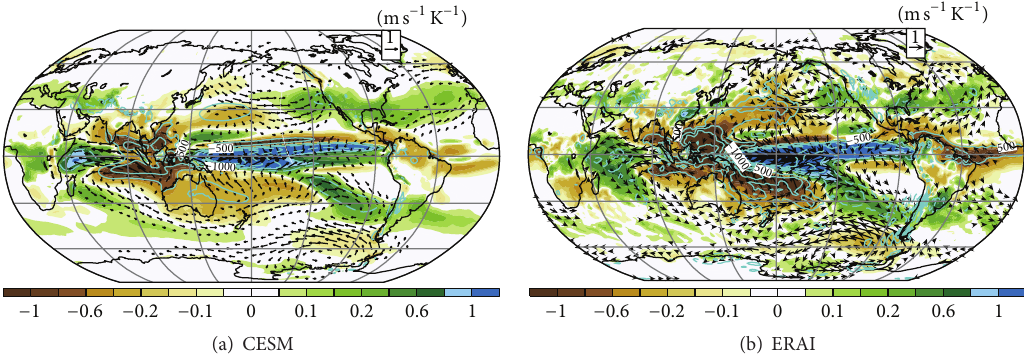
Figure 1: Ni˜no3.4-regressed rainfall (colors, mm day −1 K −1 ), near-surface winds (vectors), and midtropospheric vertical velocity (lines, mb day −1 K −1 ) for (a) the CESM control run and (b) the ERA-Interim (ERAI) reanalyses.